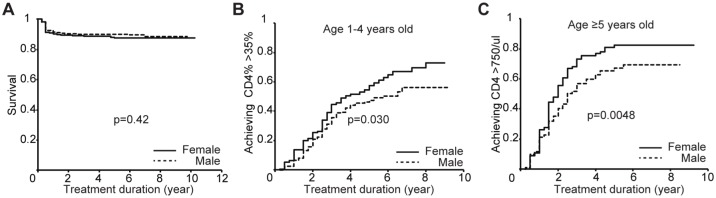
Sex differences in immune reconstitution amongst the patients started treatment under the pre-2013 WHO guidelines.Sex differences by log rank test are shown as follows: A. Survival after ART initiation. B. CD4+ T cell percentage recovery (>35%) rate among the children who started ART aged 1–4 years old with CD4+ T cell <25%. C. Absolute CD4+ T cell count recovery (>750/ul) among children initiating ART aged ≥5 years old with absolute CD4+ T cell counts <350/ul.